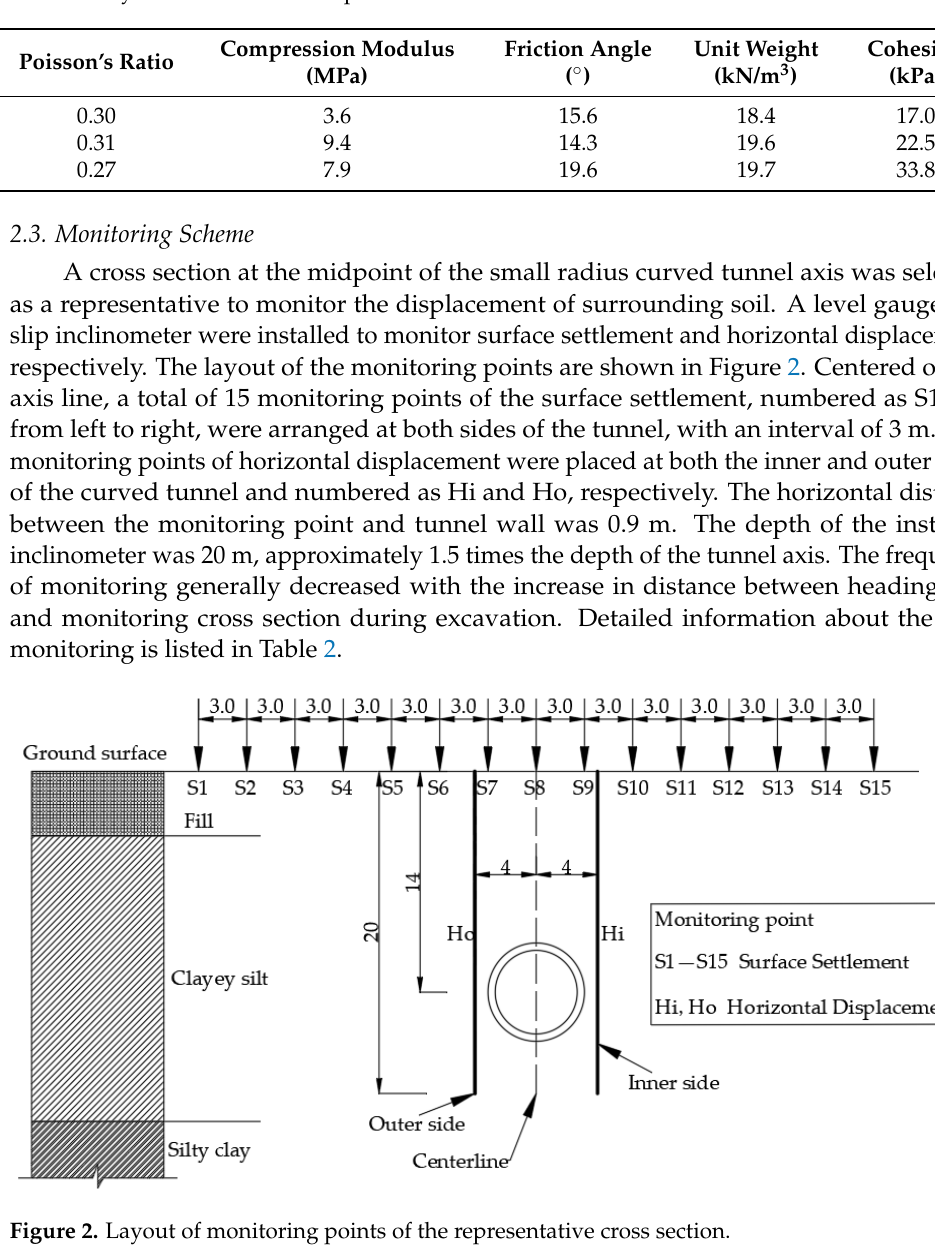
Table 1. Physical and mechanical parameters of soil.